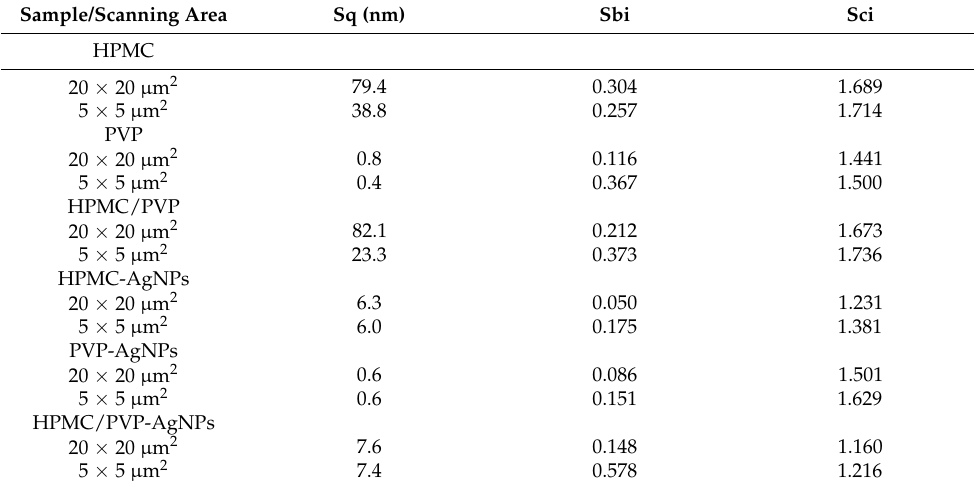
Table 3. Texture roughness parameters: root mean square roughness, (Sq), surface bearing index (Sbi), surface core fluid retention index (Sci) collected on 20 × 20 µ m 2 and 5 × 5 µ m 2 AFM images for HPMC, PVP and HPMC/PVP samples before and after incorporating